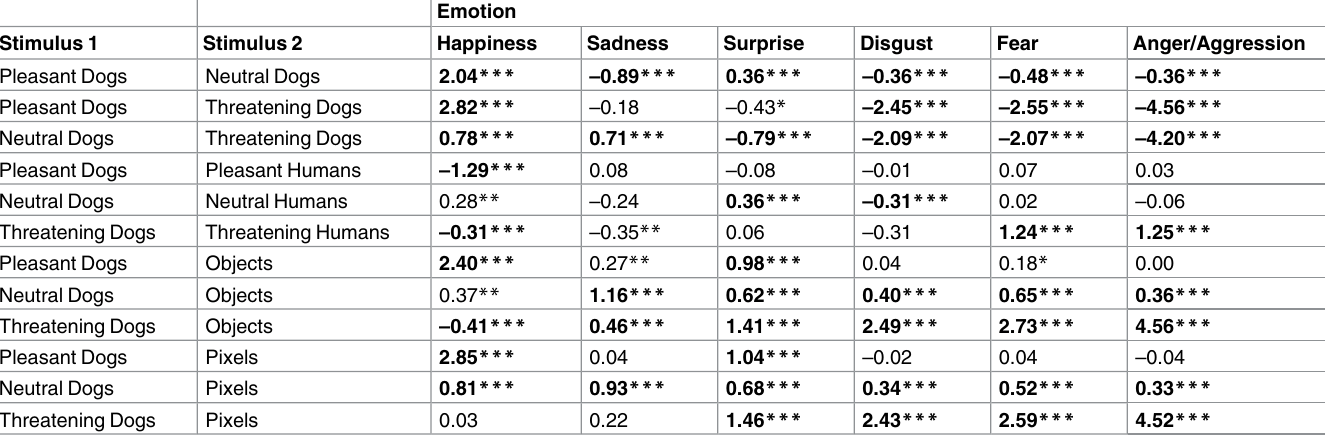
Table 2. Differenceof emotion ratings between stimuli. Plannedcomparisons of the subject ratings of discrete emotionsbetweendog expressions and other stimulus categories (Stimulus 1 vs . Stimulus 2). Ratingswere comparedbetweendog expressions, dog vs . humanexpressions, and dog expressions vs . objects and pixels. Significantdifferences are marked on the beta values with asterisks ( * p < 0.05, ** p < 0.01, *** p < 0.001) and the results with p-values abovethe FDR threshold are written in bold